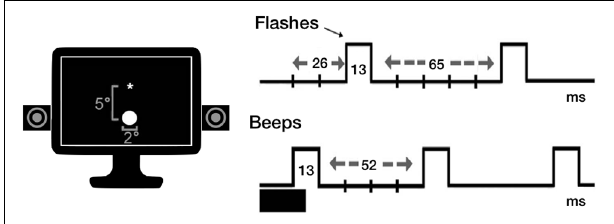
FIGURE 1 | Overview of the stimuli used for SiFI